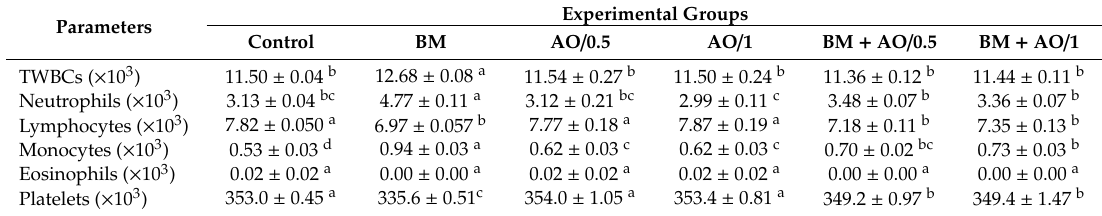
Table 3. E ff ect of betamethasone and / or argan oil on leukogram parameters and blood platelets of di ff erent treated